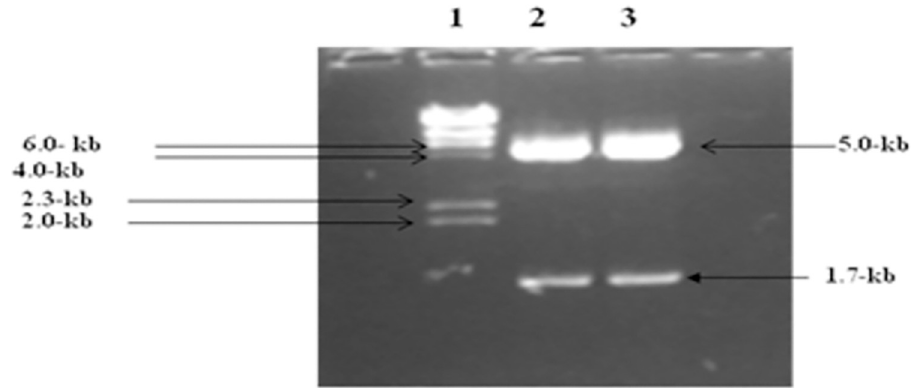
Fig 4. Plasmid pcDNA3.1+/P2X4 restriction digestion after mini prep. Lane 1 showed: λ HindIII digested marker, Lanes 2 and 3 showing digested plasmid with release of insert, pcDNA 3.1+ mammalian expression vector (5.0-kb), Insert P2X4 (1.7-kb).